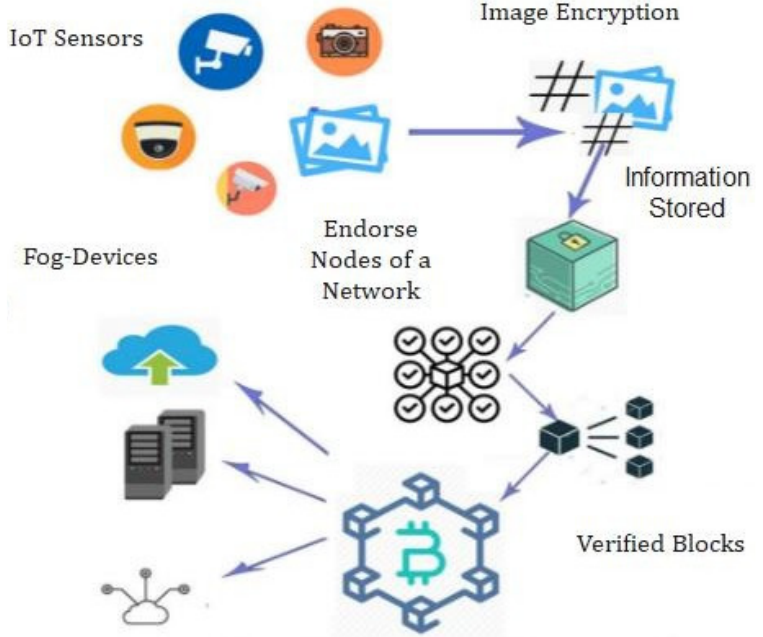
Figure 7. Proposed Neural Network system for fog-computing.